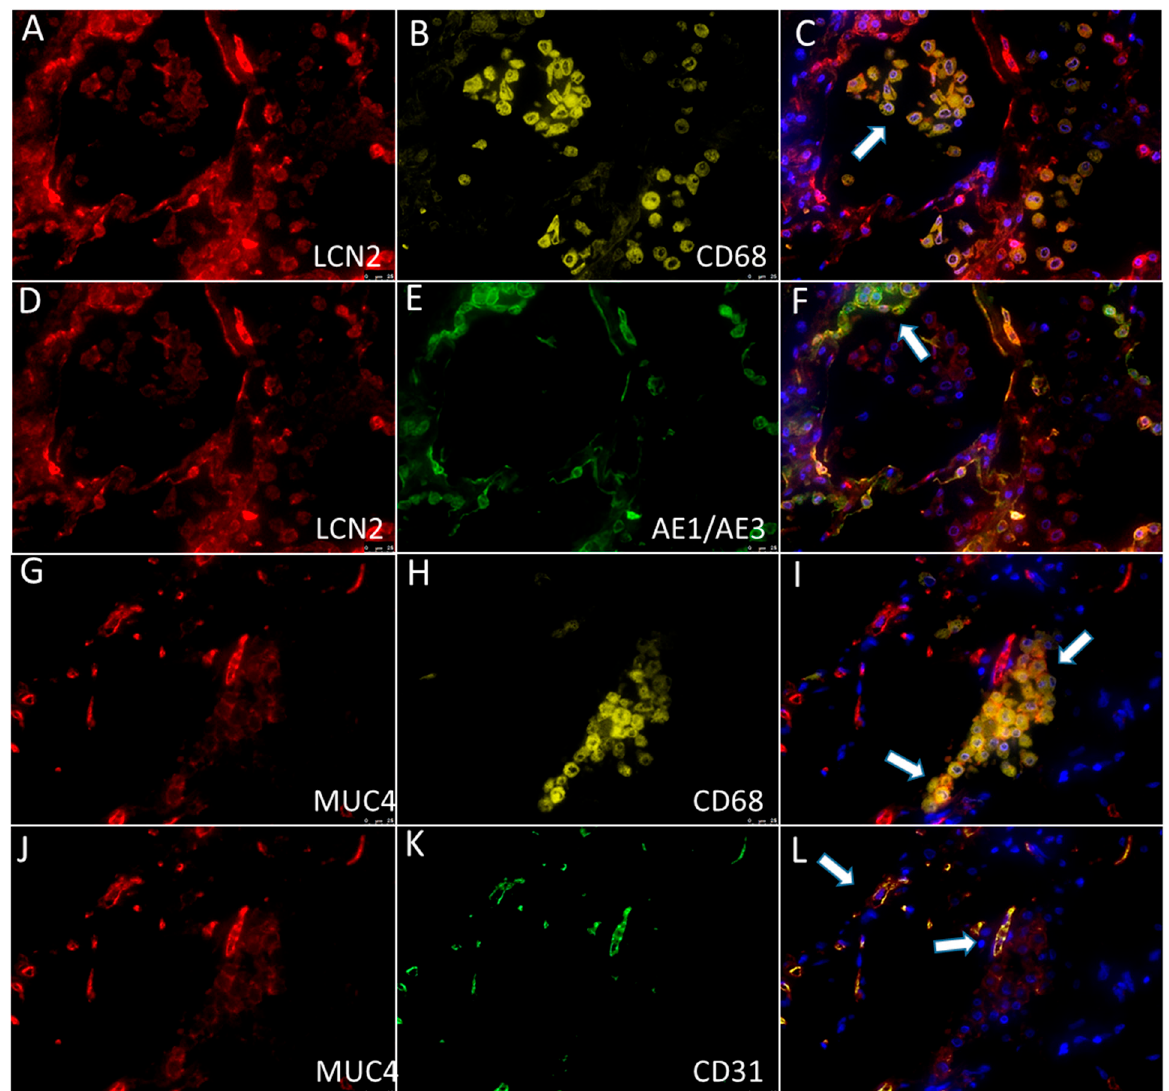
Figure 5. Multiplex immunofluorescence showed the expression of ( A , D ; red) LCN2 in ( B ; yellow) CD68+ macrophages ( C ; the overlay image of A , B ; arrow) and ( E ; green) AE1/AE3+ epithelial cells ( F ; the overlay image of A , E ; arrow). Multiplex immunofluorescence showed the expression of ( G , J ; red) MUC4 in ( H ; yellow) CD68+ macrophages ( I ; the overlay image of G , H ; arrows) and ( K ; green) CD31+ endothelial cells ( L ; the overlay image of J , K ; arrows).